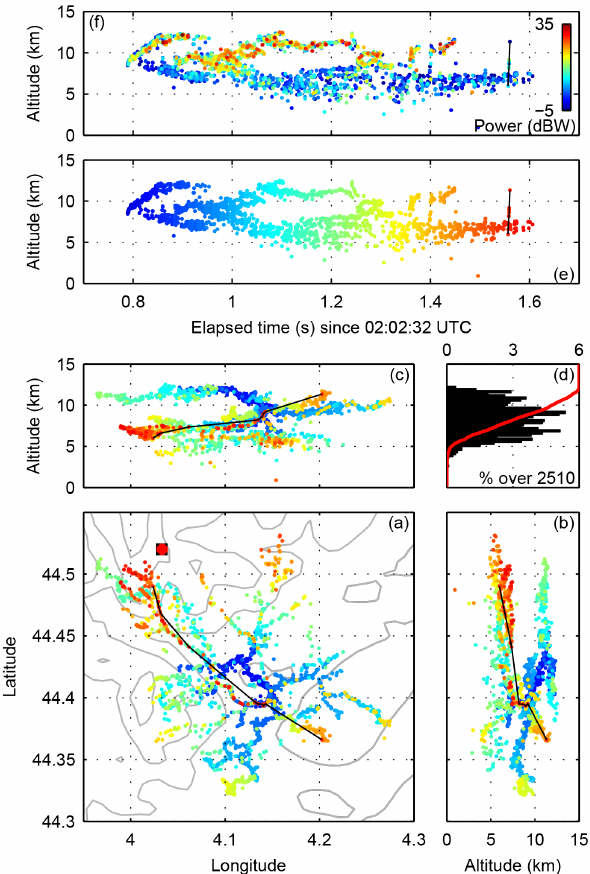
Figure 3. HyLMA records during a regular IC flash (24 Septem- ber 2012, 02:02:32UTC) with (a) ground projection of the lightning records with 200m increment relief isolines; (b) latitude–altitude projection of the lightning records; (c) longitude–altitude projec- tion of the lightning records; (d) 250m increment histogram (bars) and cumulative distribution (red cure) of the VHF source altitude; (e) time–height series of VHF sources; and (f) amplitude–height series of VHF sources. The black lines join the successive VHF sources recorded during the K change event at 02:02:33.557UTC.